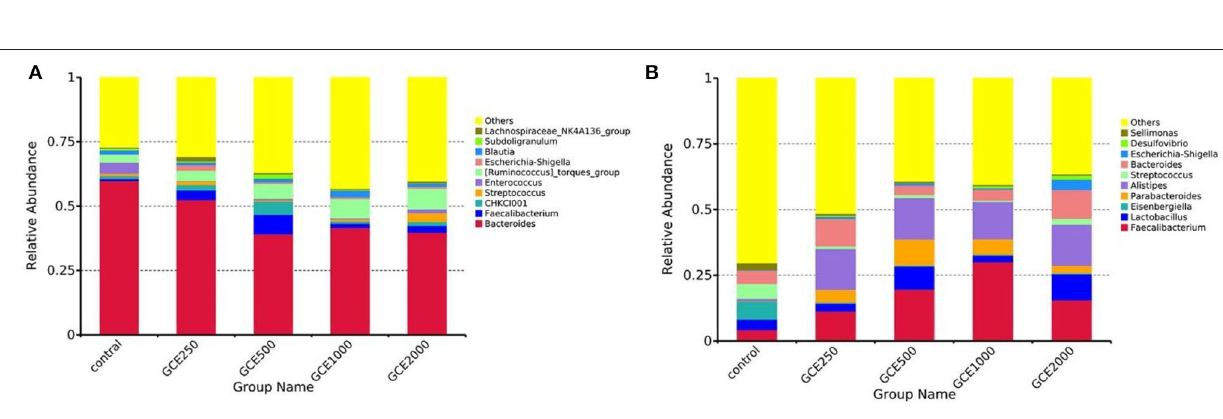
Frontiers in Animal Science |